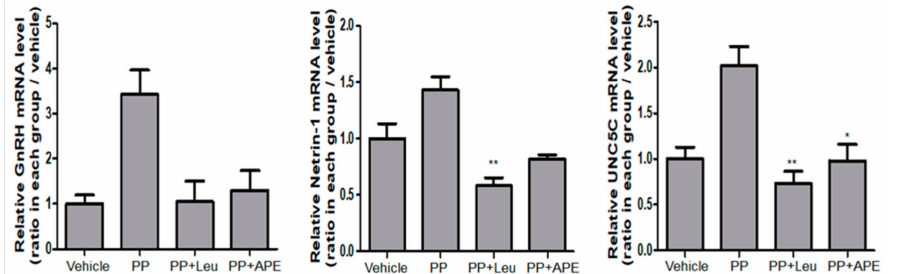
Figure 6. Effect of APE on mRNA expression of hypothalamic GnRH, netrin-1, and UNC5C. * p < 0.05; ** p < 0.01, compared to the PP group.